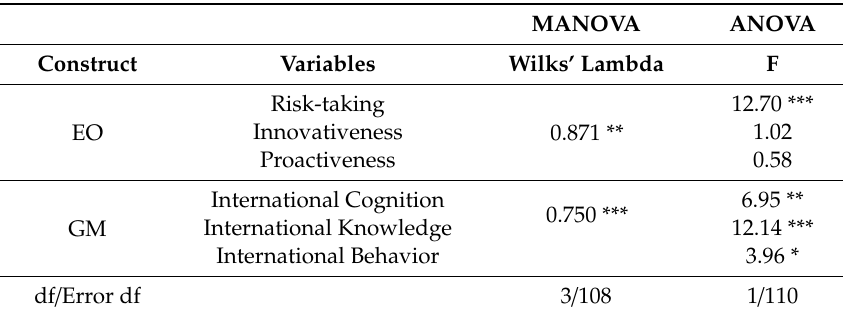
Table 3. Results of MANOVA, ANOVA, and Mann-Whitney- U